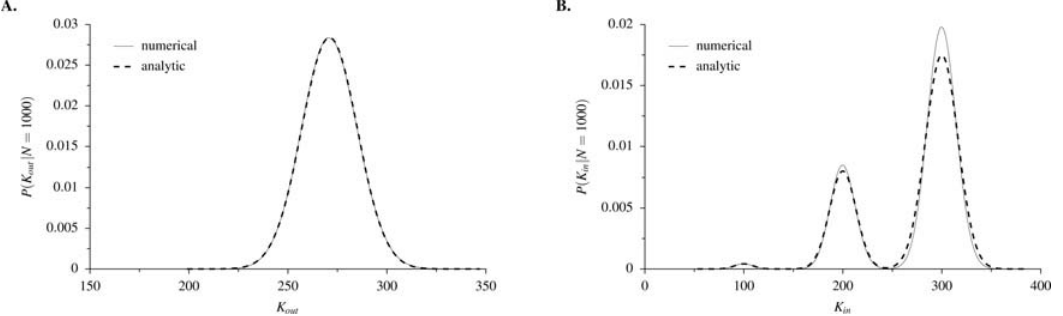
Figure 4. Numerical and analytic degree distributions for large networks. (A) Out-degree and (B) in-degree distributions for networks of size N =1000. Numerical distributions are constructed from 10 6 independent, randomly generated networks with parameter values r =10 and l